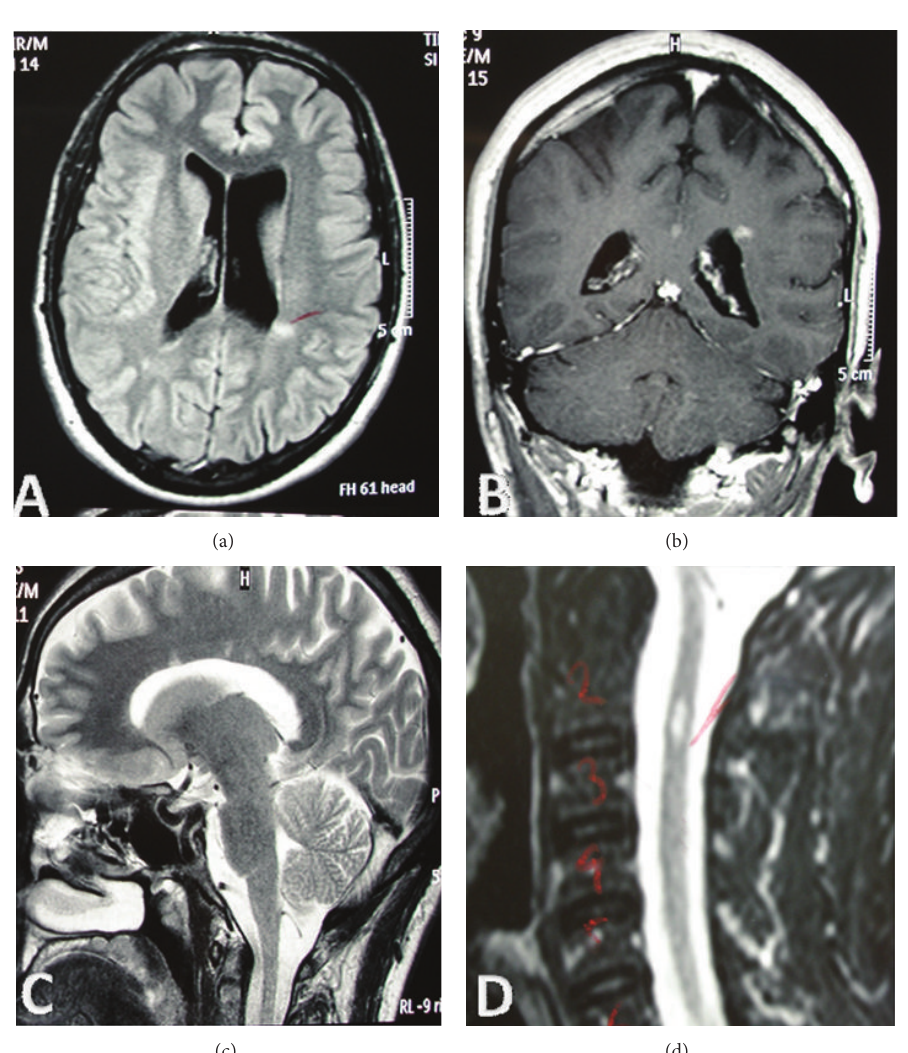
Figure 1: Magnetic resonance imaging of the brain and spinal cord at first attack, showing lesions indicative of multiple sclerosis. (a) Axial FLAIR image showing hyperintense lesions in the white matter of both hemispheres. (b) Coronal T1-weighted image showing a gadolinium- enhancinglesionneartheleftlateralventricle.(c)SagittalT2-weightedimageshowinglesionsinthecorpuscallosum.(d)SagittalT2-weighted image showing a hyperintense lesion on cervical spinal cord at C2